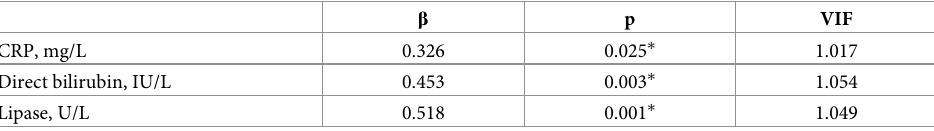
Table 5. Multiple regression model affecting physician-guided cannulation time (N = 32).